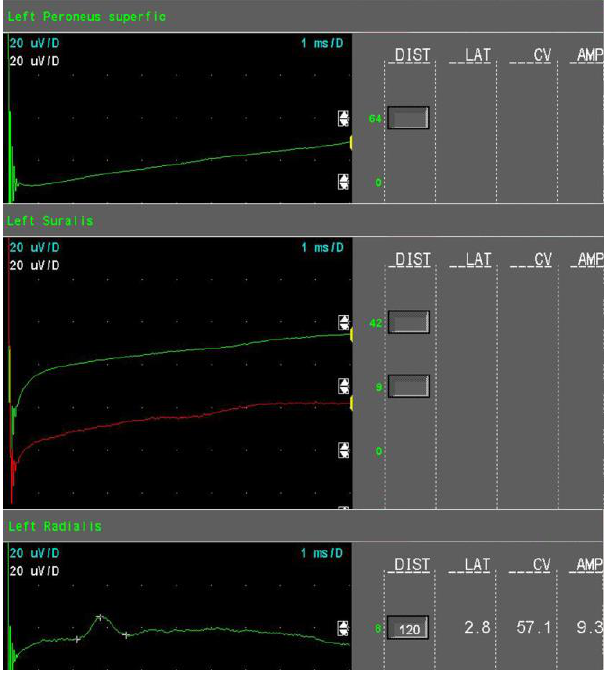
Figure 3. Sensory nerve conduction studies in severe sensory axonal loss (example).